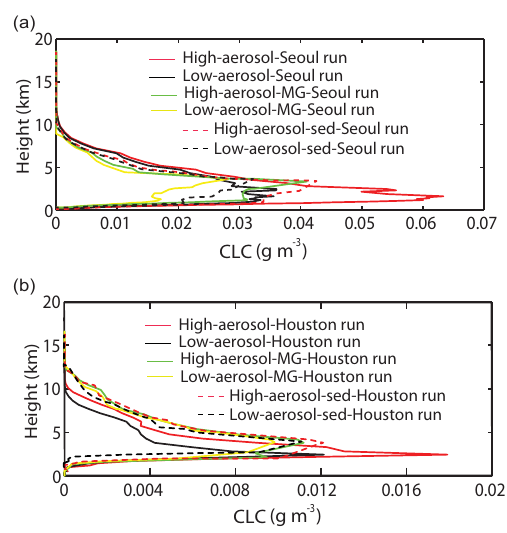
Figure 14. Vertical distributions of the time- and domain-averaged cloud liquid content (CLC) for (a) the Seoul case and (b) the Hous- ton case. Solid red and black lines represent simulations with the bin scheme and at the 500m resolution, while dashed red and black lines represent the bin-scheme simulations with the saturation ad- justment and the MG-scheme sedimentation process. Solid yellow and green lines represent simulations with the MG